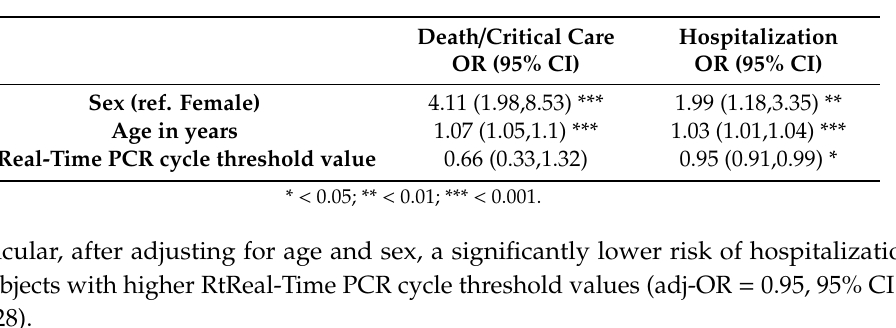
Table 4. Multinomial regression analyses on variables associated with major clinical outcomes (death / critical care or hospitalization vs. home